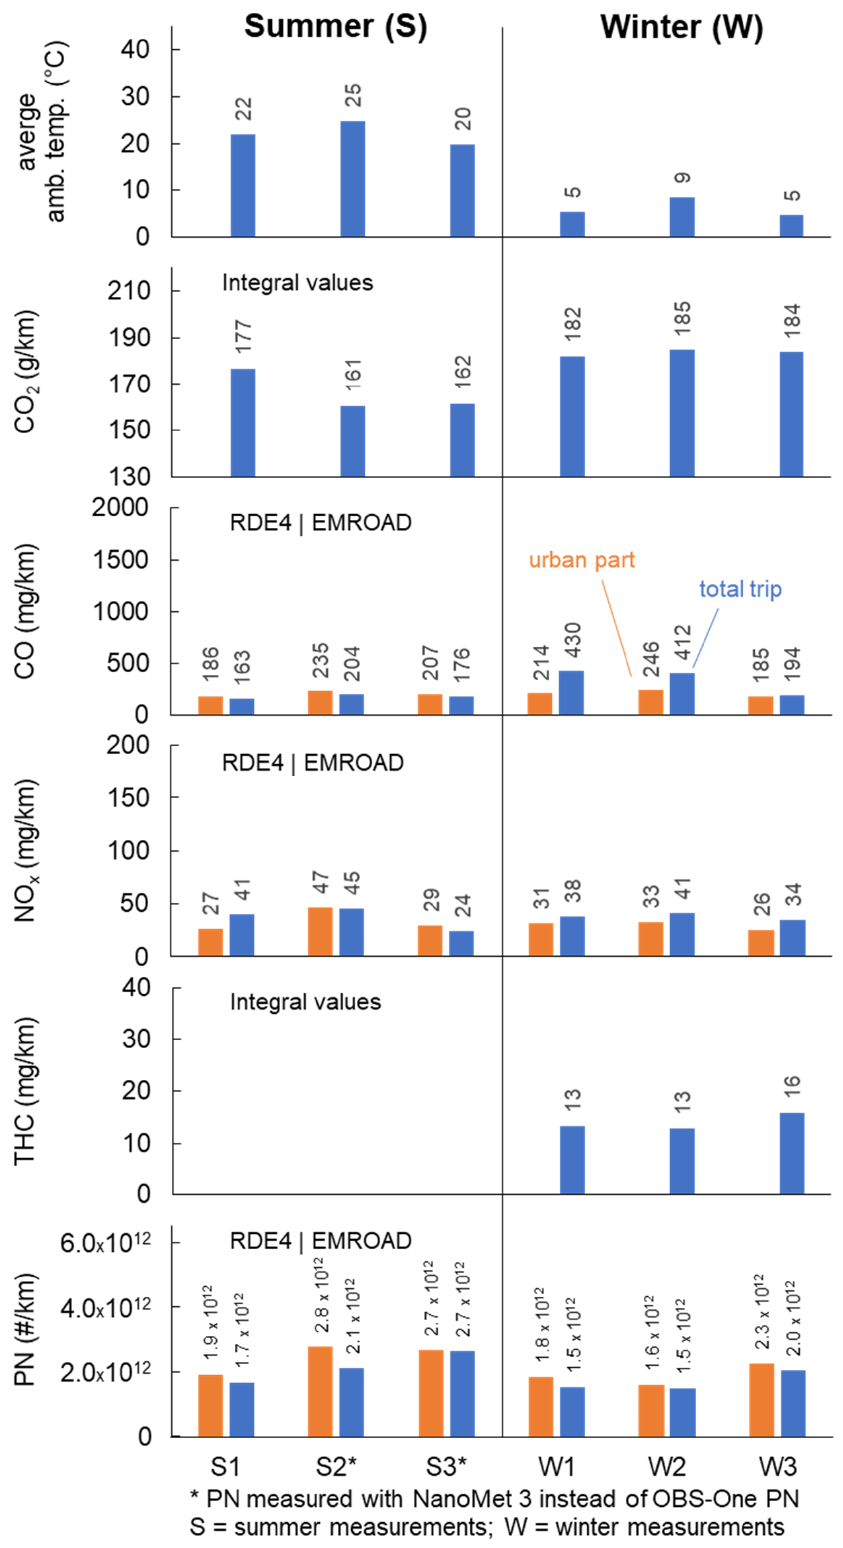
Figure 2. Comparison of real driving emissions in summer and winter conditions, official RDE route, integral average values, vehicle 1, gasoline.